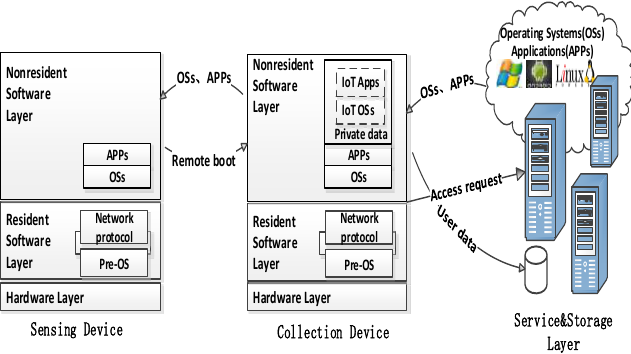
Figure 4. The architecture of the sensing and aggregation